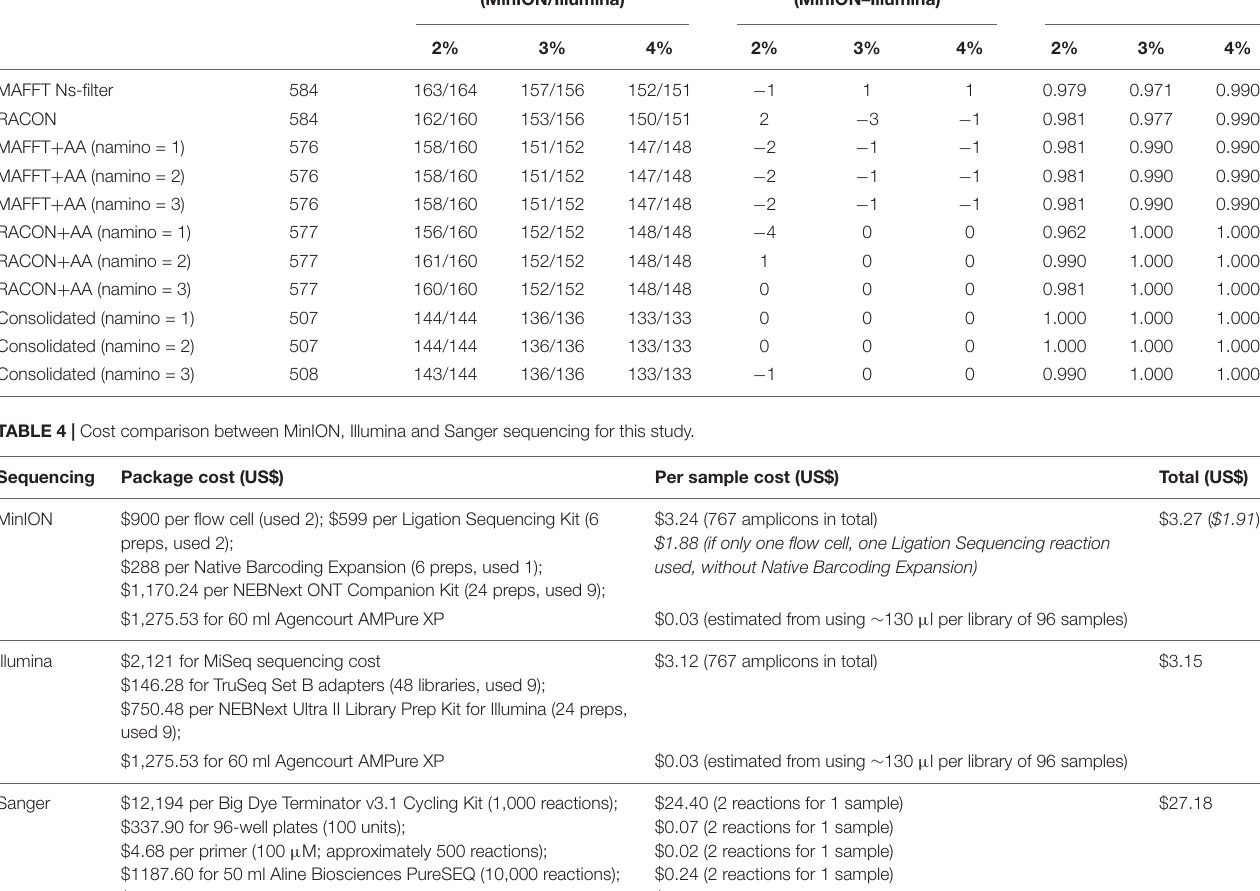
TABLE 3 | The number of molecular operational taxonomic units (MOTUs) obtained for each overlapping dataset at 2–4% threshold, and the differences in MOTUs between MinION (‘ half ” dataset) and Illumina datasets. Barcode